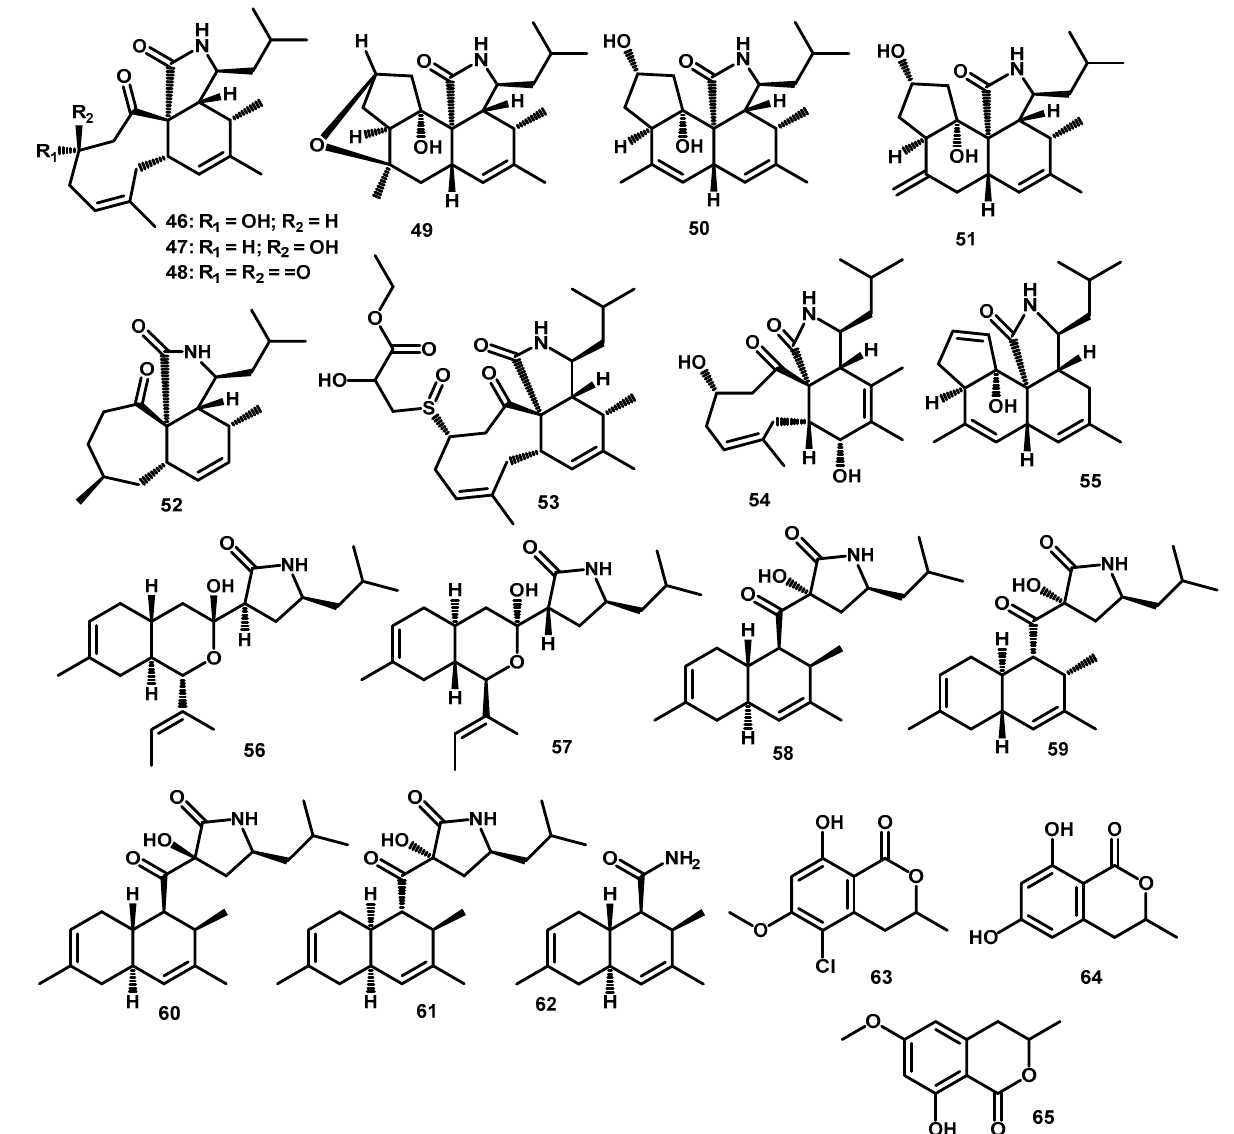
Figure 4. The chemical structures of polyketides 46 – 65 from the Periconia genus.